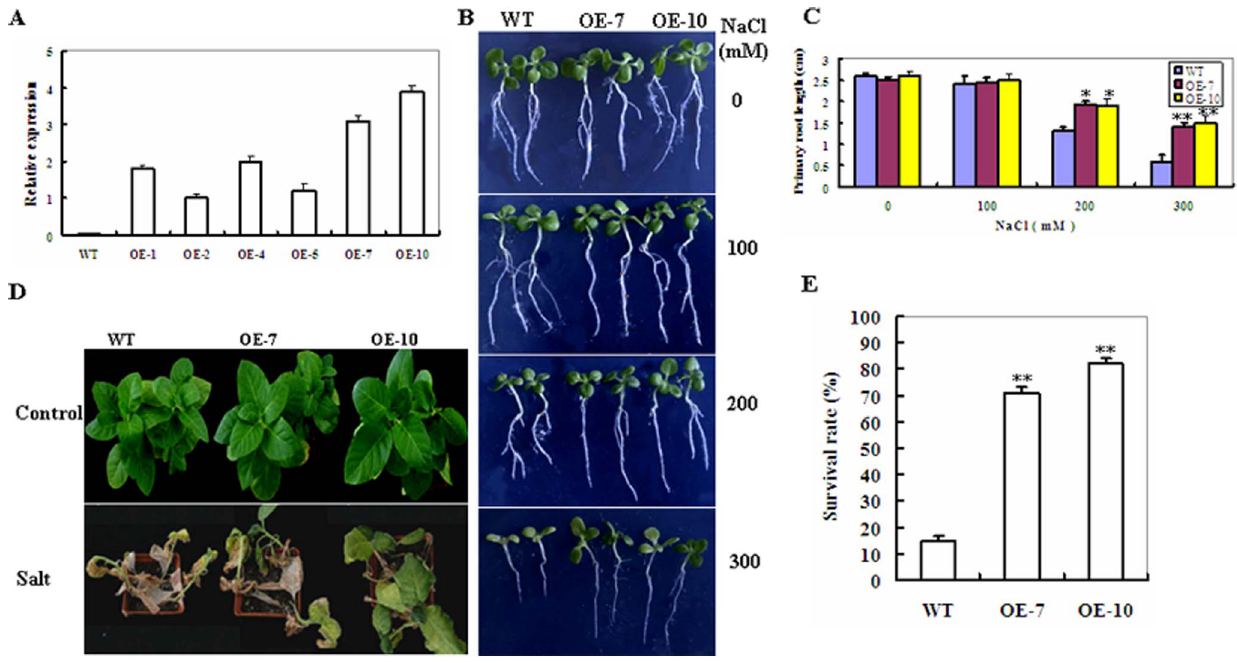
Figure 3. Phenotypes of wild-type and ZmSKD1 -overexpressing tobacco plants in response to salt stress. A Transcription levels of ZmSKD1 in wild-type (WT) tobacco plants and six homozygous over-expression (OE) lines (named OE-1, OE-2, OE-4, OE-5, OE-7 and OE-10). ZmSKD1 transcripts detected by qPCR were present in the OE lines, but not in the wild-type plants. B Growth phenotypes of 2-week-old WT and transgenic OE (OE-7 and OE-10) seedlings vertically growing on 1/2 MS medium supplemented with 0, 100, 200 and 300 mM NaCl for 10 d. C Primary root length of 10 d-salt stressed plants in Fig. B. Values are mean 6 SE, n=10. **t-test, with P , 0.01; *t-test, with P , 0.05. D Representative phenotype of 6-week-old WT and transgenic OE plants growing in soil pots supplied with 0 (water) or 300 mM NaCl solution every other day for 4 weeks. E Survival rates (%) under salinity stress in Fig. D were determined as the number of visibly green plants after 4 weeks. Values are mean 6 SE, n=10. **t-test, with P ,